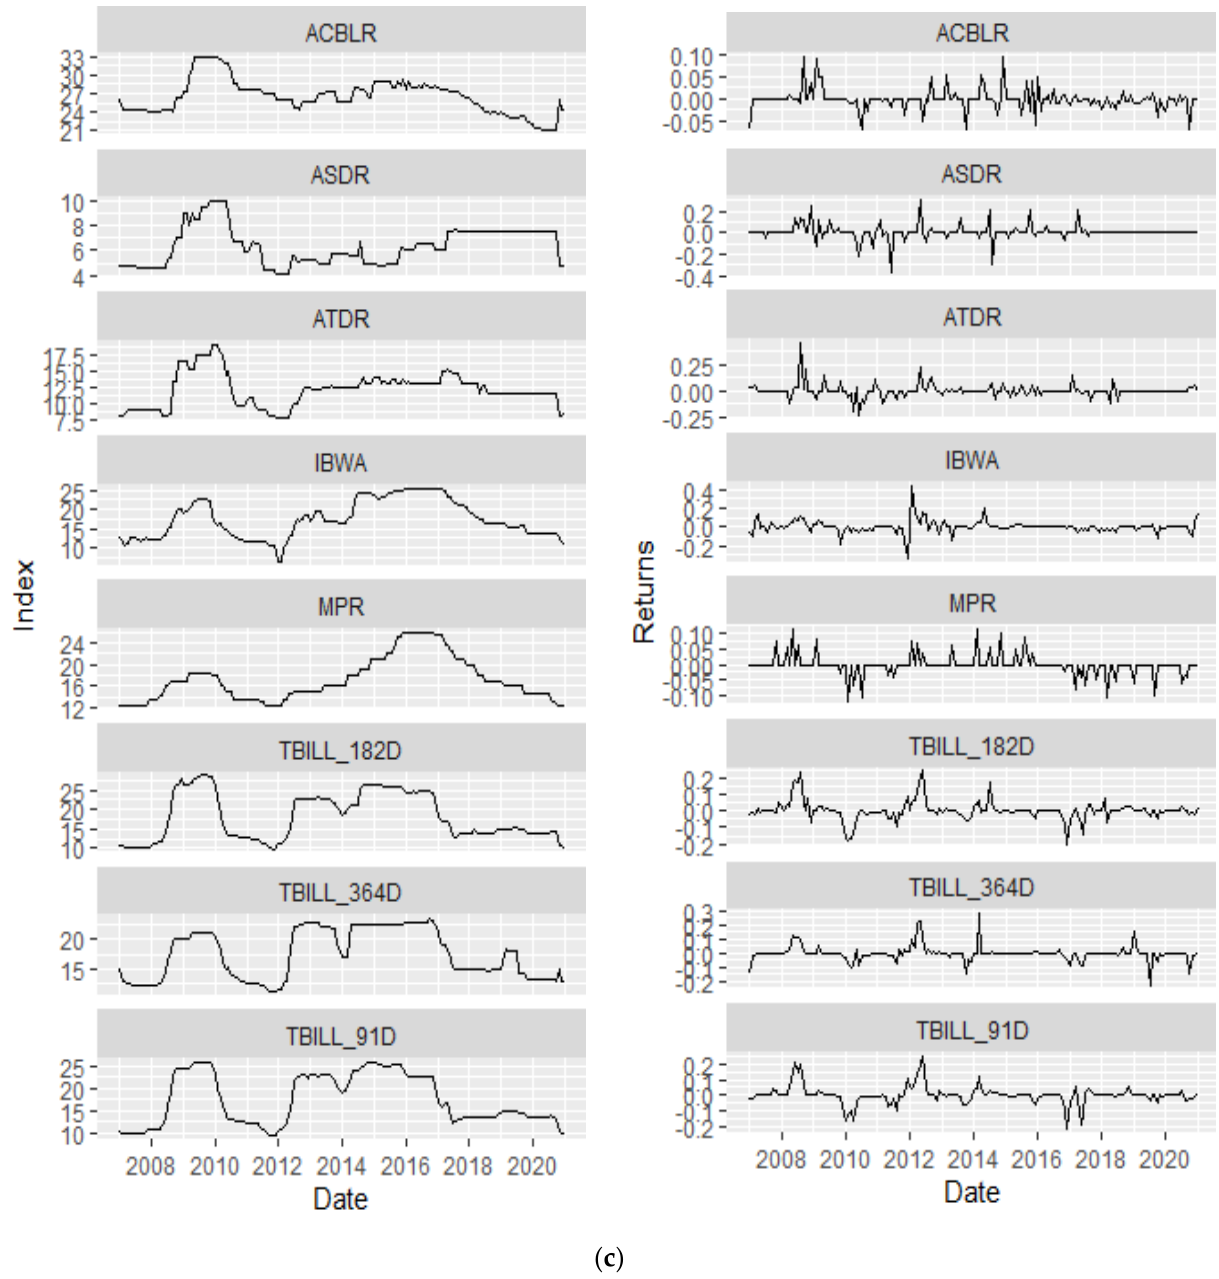
Figure 3. Plots of indexes and returns series. ( a ) Series of indicators of the Ghana Stock Exchange. ( b ) Series of the banking sector financial soundness measures. ( c ) Series of interest rate measures